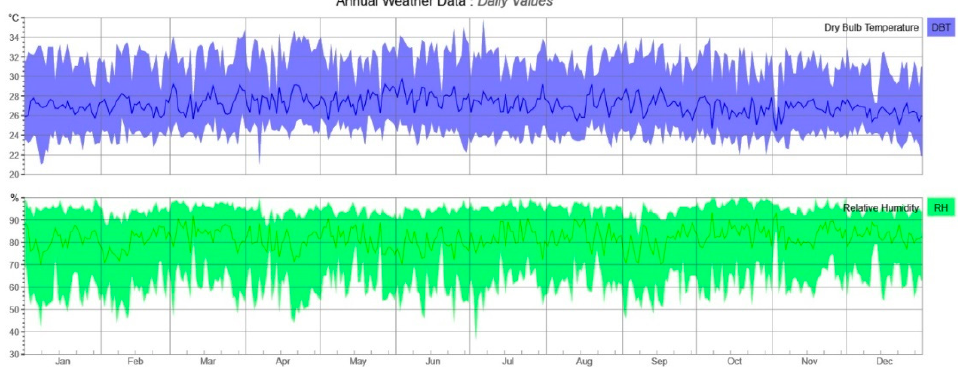
Figure 4. Weather data of air temperature and relative humidity for Kuala Lumpur, Malaysia [46].